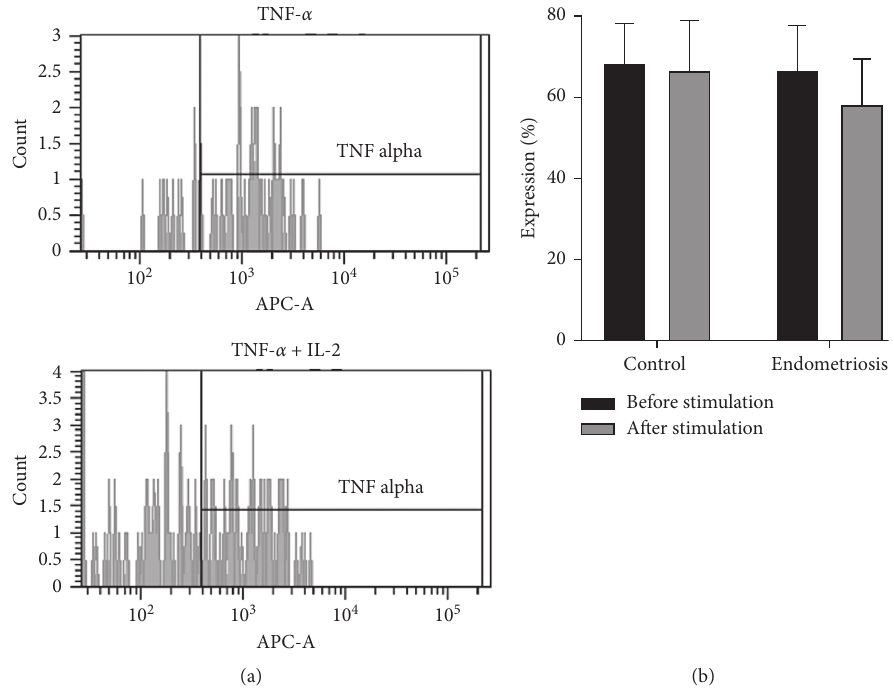
Figure 2: Expression of TNF- α in the presence and absence of IL-2. (a) Population of TNF- α + cells as determined by flow cytometry analysis. (b) Expression of TNF- α before and after IL-2 stimulation. The differences before and after IL-2 stimulation were analyzed by paired t -test.